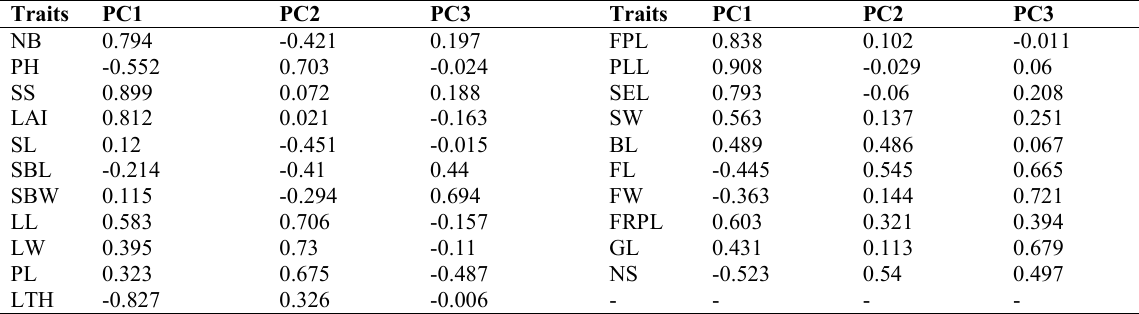
Table 3. Vector loadings explained by the first three